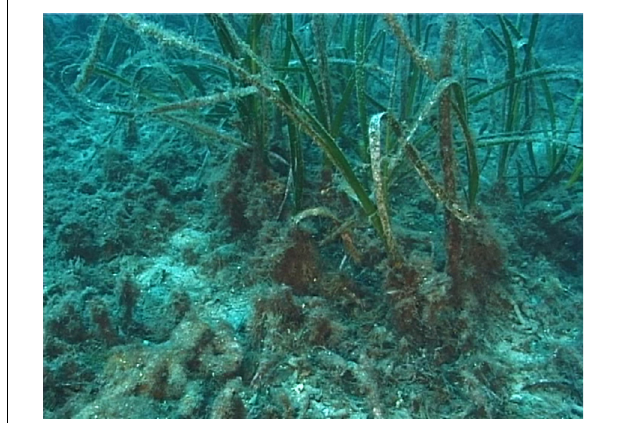
FIGURE 1 | A Posidonia oceanica meadow severely degraded under and in the vicinity of a fish farm. Bay of Calvi (Corsica). Photo © Gérard Pergent.